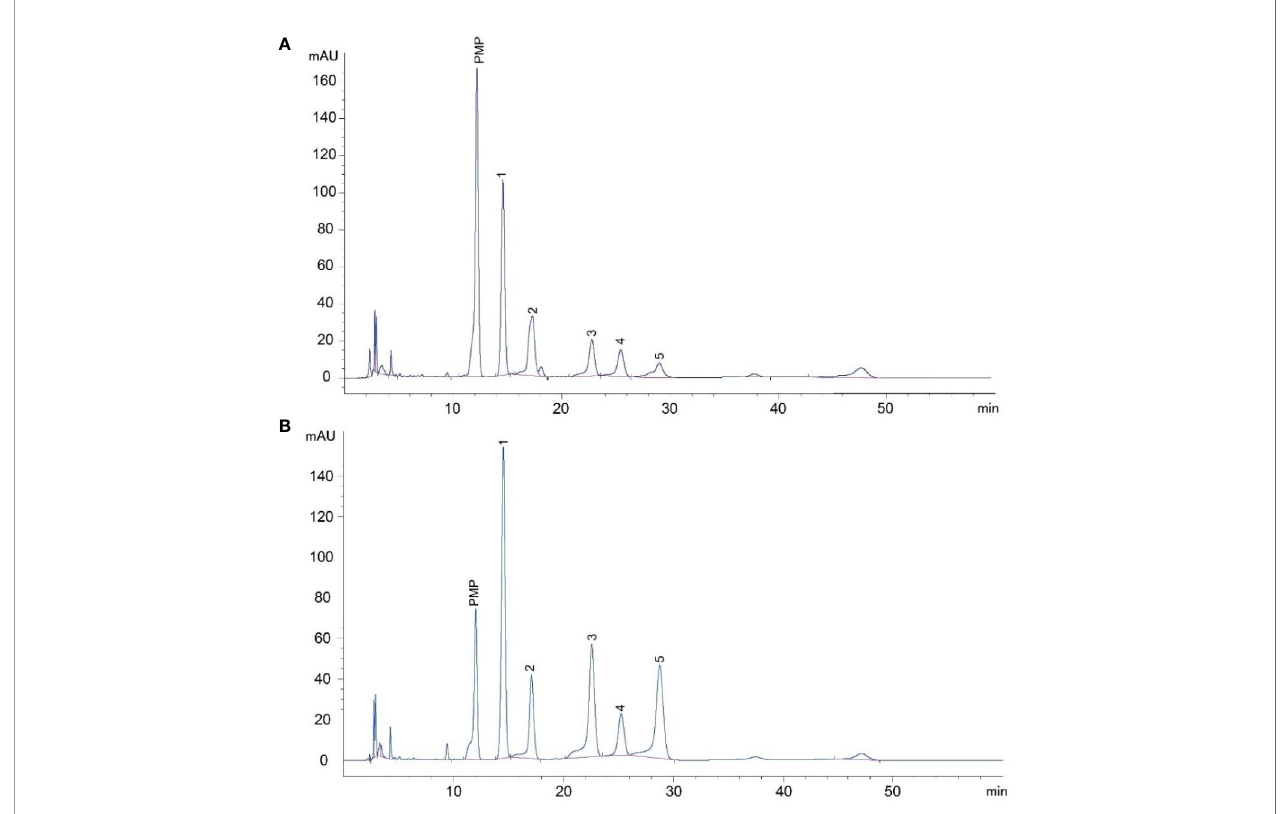
FIGURE 1 | HPLC analysis of LDOP monosaccharide composition. (A) The composition of LDOP by HPLC analysis; 1: mannose, 2: galacturonic acid, 3: glucose, 4: galactose, 5: arabinose. (B) Standard monosaccharides. LDOP: The total polysaccharide from Dendrobium of fi cinale Kimura &